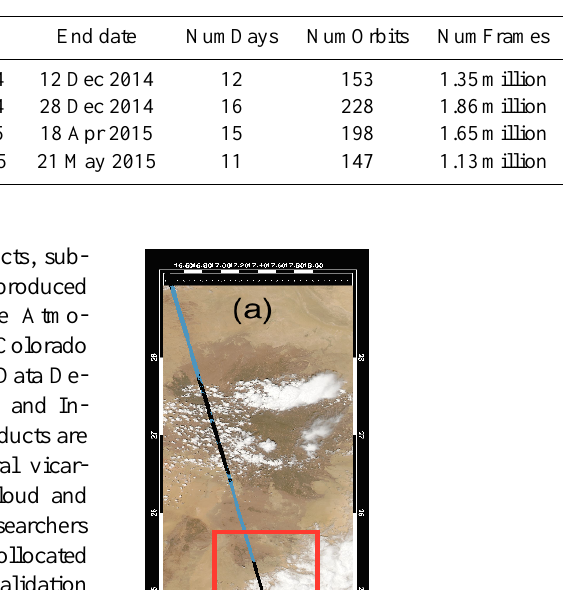
Table 2. Summary of OCO-2 B7 data set to which MODIS and CALIOP collocation were performed. Note that each OCO-2 frame contains eight footprints, i.e., eight soundings.